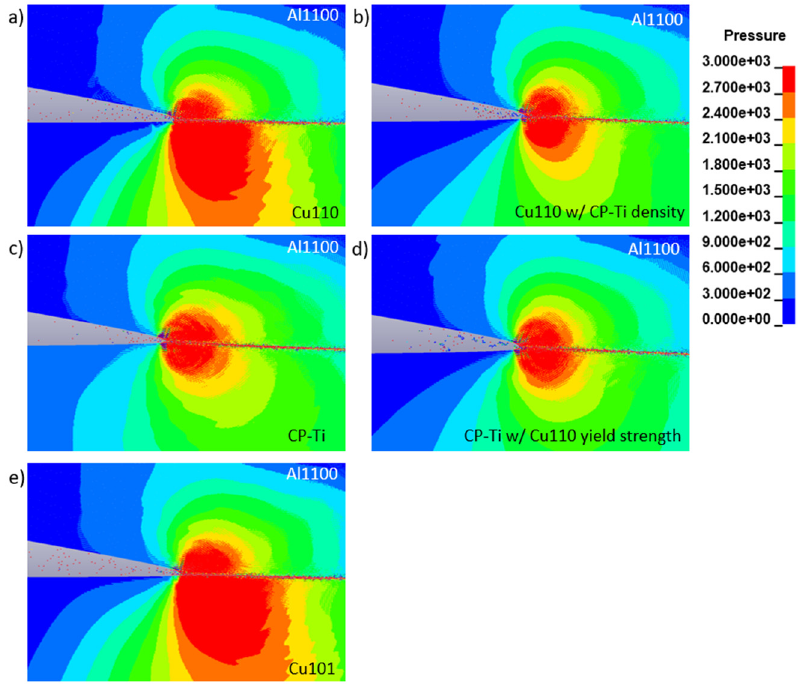
Figure 14. Contact pressures at the interfaces for Al1100 & ( a ) Cu110, ( b ) fictitious Cu110 with the density of CP-Ti, ( c ) CP-Ti, ( d ) fictitious CP-Ti with the yield strength of Cu110, and ( e ) Cu101.